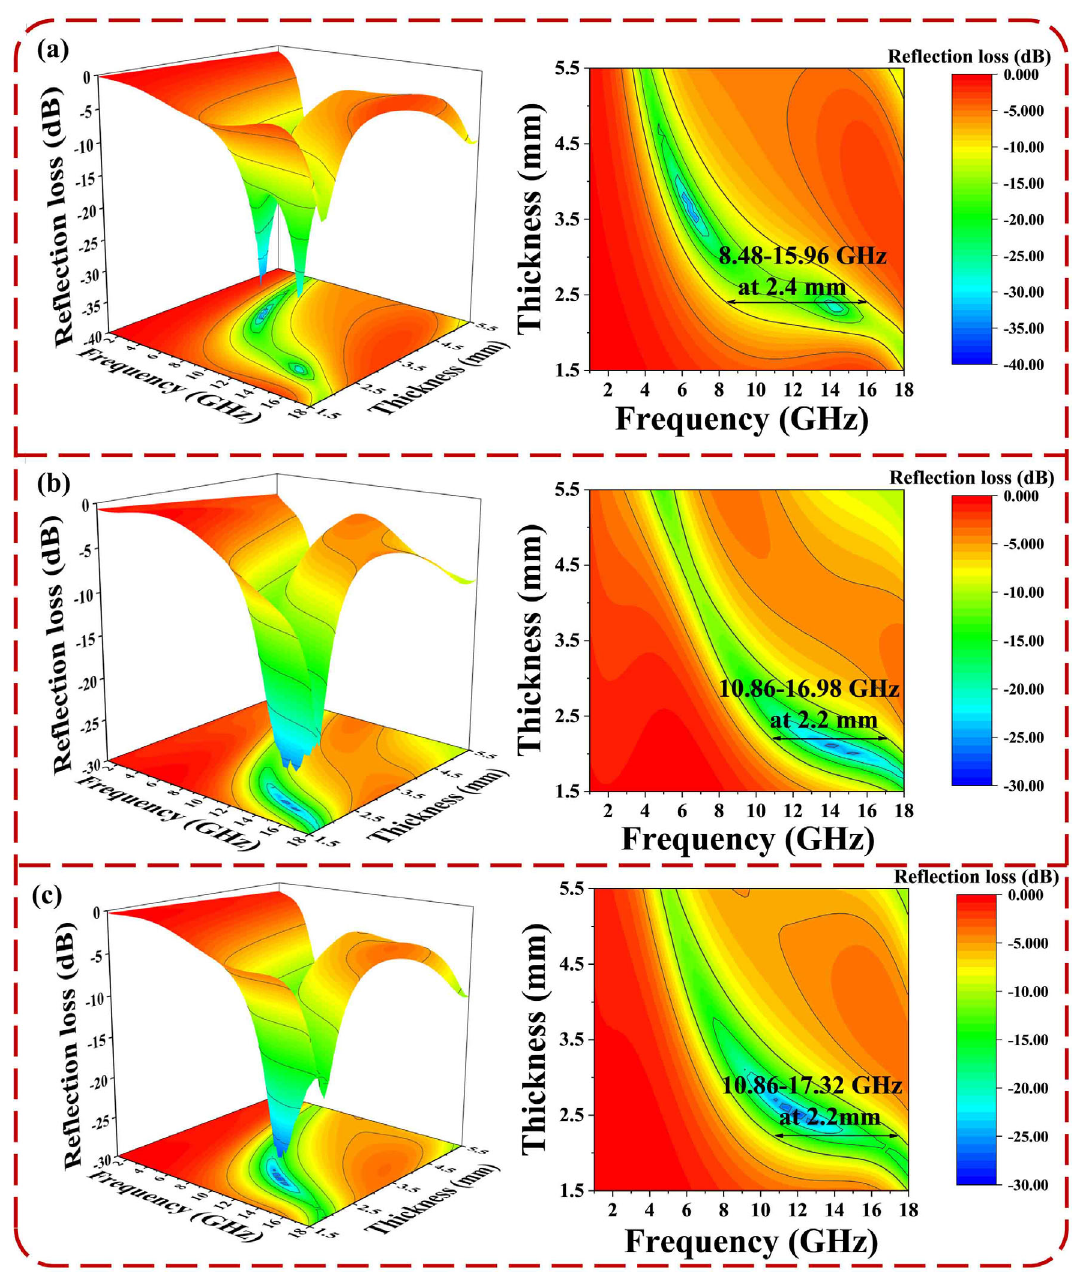
Fig. 10 3D representations of RL values and 2D contour plots of (a) (Mg 0.2 Mn 0.2 Fe 0.2 Co 0.2 Ni 0.2 )Fe 2 O 4 , (b) (Mg 0.2 Fe 0.2 Co 0.2 Ni 0.2 Cu 0.2 )Fe 2 O 4 , and (c) (Mg 0.2 Fe 0.2 Co 0.2 Ni 0.2 Zn 0.2 )Fe 2 O 4